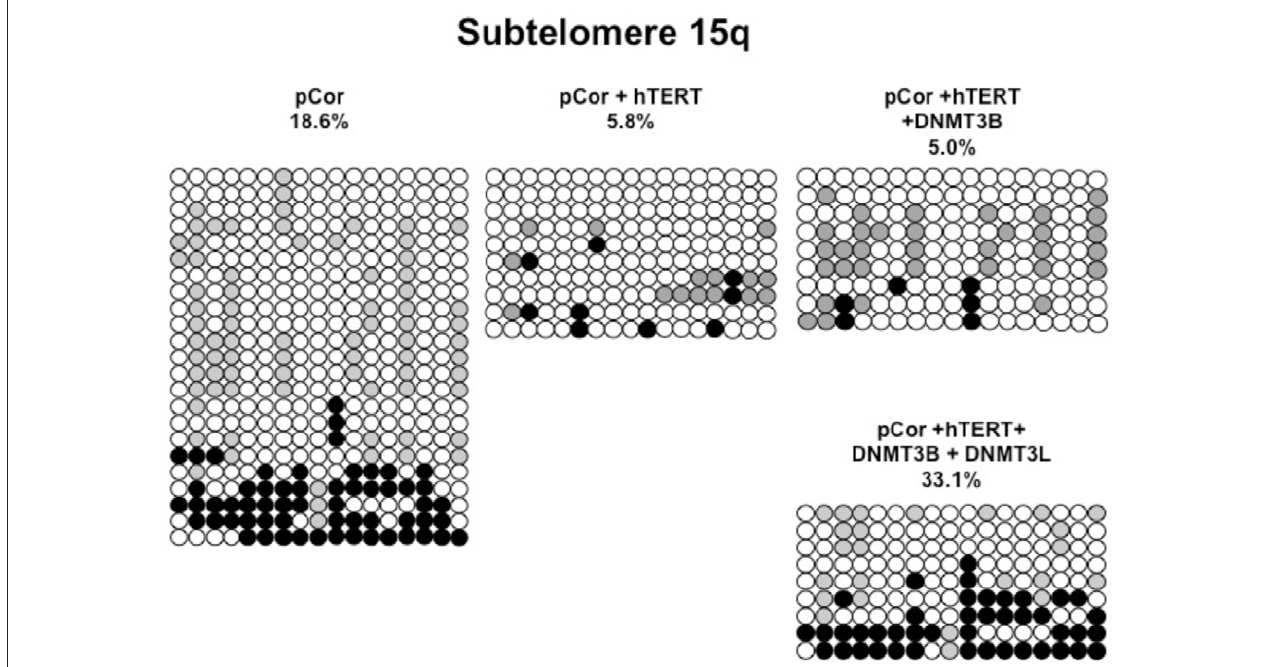
FIGURE A7 | Bisulfite analysis of subtelomeric region 15q. Bisulfite sequence analysis was carried out for a region in subtelomere 15q in pCor, pCor + hTERT, pCor + hTERT + DNMT3B1 and pCor + hTERT + DNMT3B1 + DNMT3L fibroblasts. The analyzed region contains 17 CpG sites. White circles represent unmethylated CpG